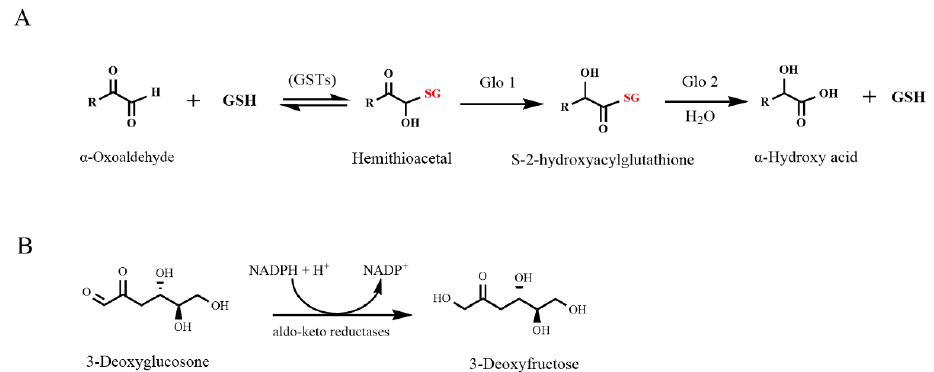
Figure 1. Major intracellular detoxification pathways for α‐ dicarbonyl compounds including ( A ) detoxification of the α‐ dicarbonyl compounds (mainly MGO and GO) by the glyoxalase system and ( A ) detoxification of the α -dicarbonyl compounds (mainly MGO and GO) by the glyoxalase ( B ) detoxification (mainly for 3 ‐ DG) by NADPH ‐ dependent aldo ‐ keto reductases. GSH: glutathione, system and ( B ) detoxification (mainly for 3-DG) by NADPH-dependent aldo-keto reductases. GSTs: glutathione ‐ S ‐ transferases, MGO: methylglyoxal, GO: glyoxal, 3 ‐ DG: 3 ‐ deoxyglucosone, GSH: glutathione, GSTs: glutathione-S-transferases, MGO: methylglyoxal, GO: glyoxal, 3-DG: Glo1: glyoxalase 1, Glo2: glyoxalase 2.